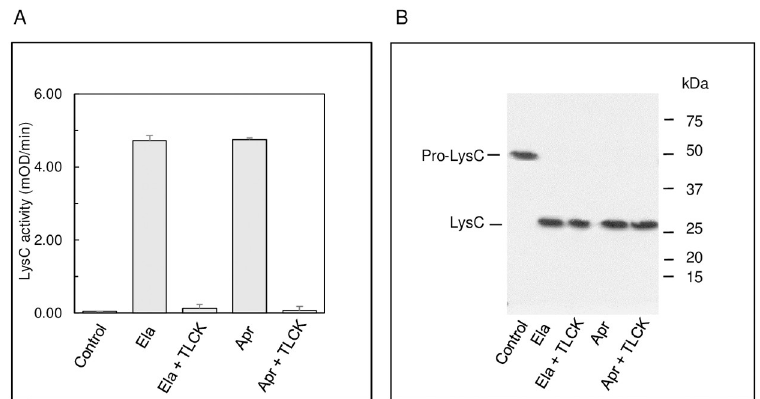
Fig 3. Ela and Apr can activate LysC. Culture filtrate samples from strain FRD1185 (Ela - Apr - LysC + ; 150 μ l) containing pro-LysC were incubated (3 h, 37˚C) in the presence (+) or absence (-) of either Ela or Apr (0.45 μ g each). A , LysC activity . The differences between the control (C), Ela plus TLCK and Apr plus TLCK are insignificant (p = 0.43 and 0.73, respectively); the difference between Ela and Apr is also insignificant (p = 0.78). The differences between control and Ela or control and Apr are significant (p = 0.0005 and 0.0008, respectively) and so are the differences between Ela vs Ela plus TLCK and Apr vs Apr plus TLCK (p = 0.00002 and 0.0003, respectively). B, Immunoblot showing that both Ela and Apr can convert pro-LysC (~50 kDa) to the 28 kDa mature enzyme. Proteins in 100 μ l of each reaction solution were precipitated with TCA, solubilized in Laemmli’s sample buffer and subjected to SDS-PAGE and immunoblotting with a LysC antibody.